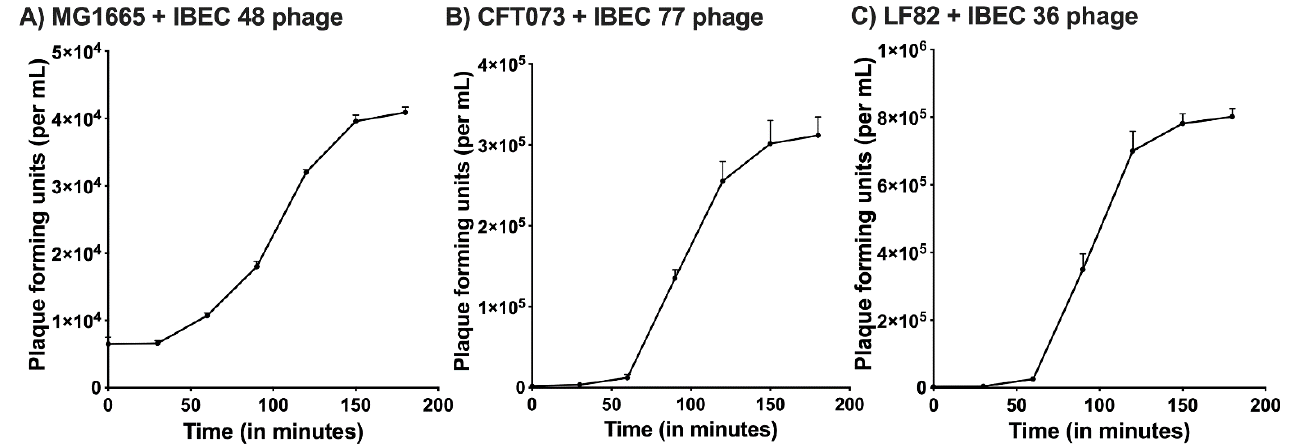
Figure 1. One-step growth curve of ( A ) IBEC48 phage, ( B ) IBEC77 phage, and ( C ) IBEC36 phage. One-step growth curves were obtained by growing IBEC 48, IBEC 77, and IBEC 36 with there expo- nentially growing culture of E. coli MG1655, E. coli CFT073, and E. coli LF82 strains respectively. Data points indicate the PFU/mL at different time points. Each data point represents the mean of three independent experiments.